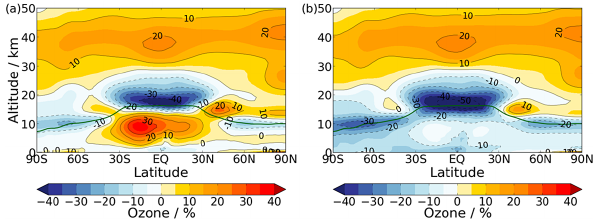
Figure 3. Annual mean, zonal mean changes (shading and contours) in ozone (%) relative to Base for (a) 1 CC8.5 and (b) 1 CC8.5( f LNO x ) . Solid green lines indicate the height of the thermal tropopause of the Base run.